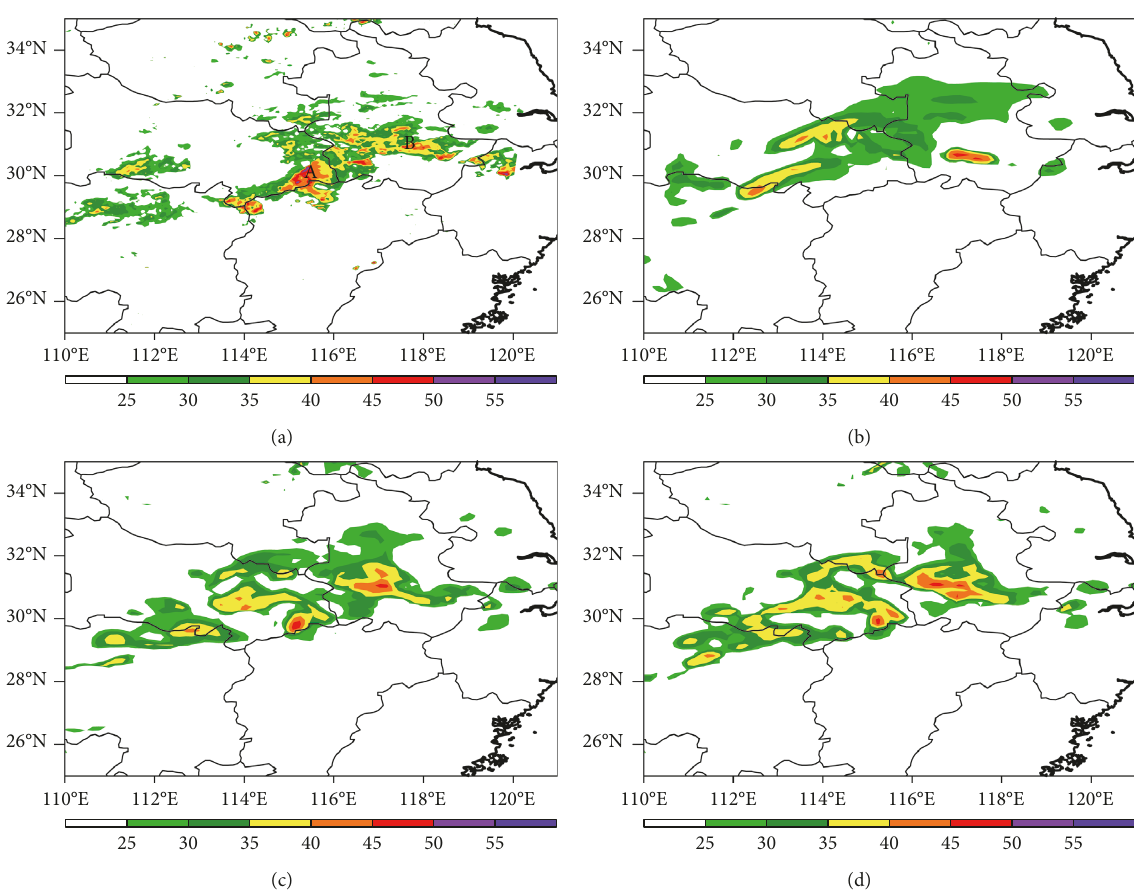
Figure 9: Radar echoes at the height of 3km at 0300 UTC 4 July 2014: (a) observations, (b) CON, (c) RAD, and (d) RADC (unit: